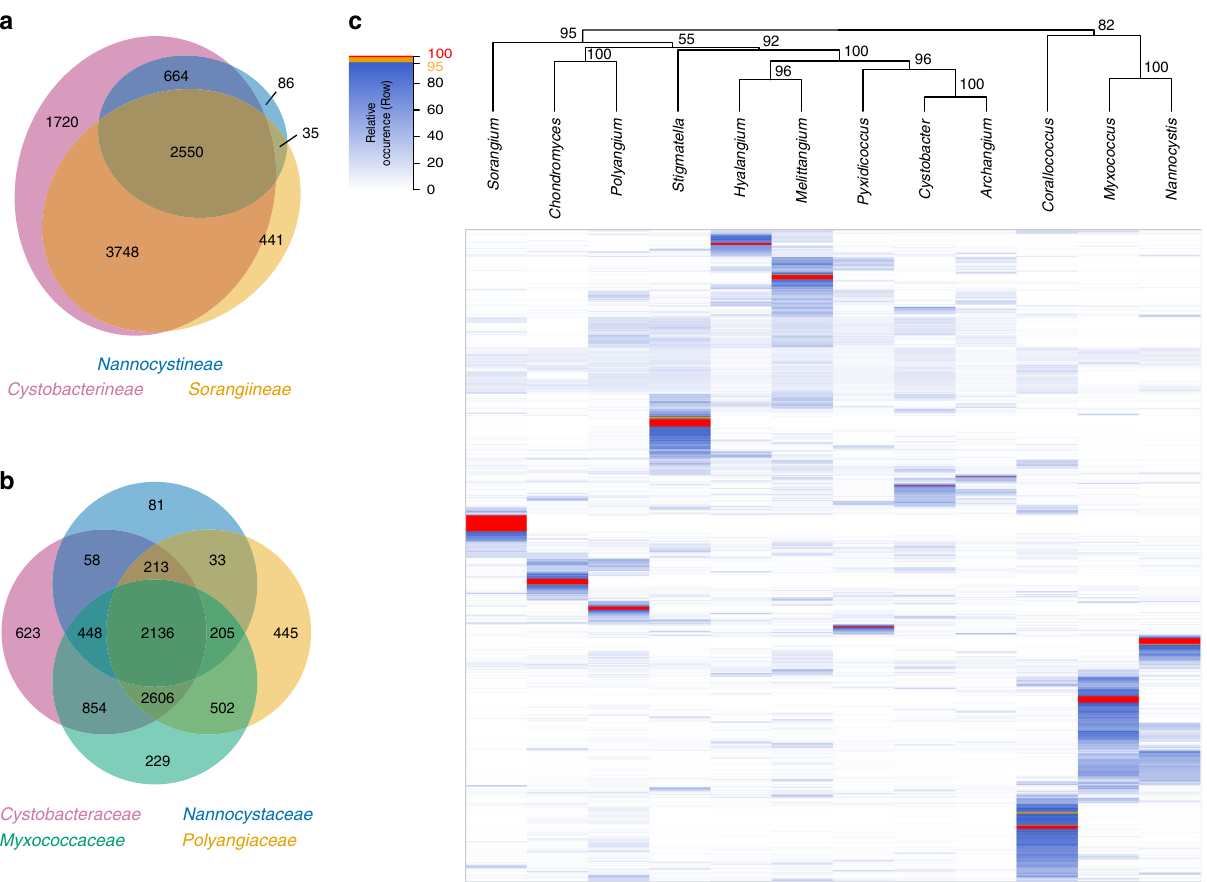
Fig. 4 Clustering of unknown features. Distribution of mass spectral buckets created from unknown features of 515 myxobacterial strain extracts shown as a Venn diagram on suborder level and b Euler plot on family level. c Heat map displaying ~9200 buckets across all data sets. The data sets are distributed as follows: Archangium (26), Chondromyces (50), Corallococcus (50), Cystobacter (50), Hyalangium (22), Melittangium (44), Myxococcus (50), Nannocystis (50), Polyangium (50), Pyxidicoccus (23), Sorangium (50), and Stigmatella (50). Individual data sets were collapsed to genus level before applying UPGMA- based hierarchical clustering. Buckets unique to a genus are shown in red, those which are highly speci fi c with >95% relative occurrence per genus are in orange (visible upon magni fi cation). Column clustering was subjected to bootstrapping ( n = 500) with ‘ approximately unbiased ’ p -values displayed. Contains no technical or biological